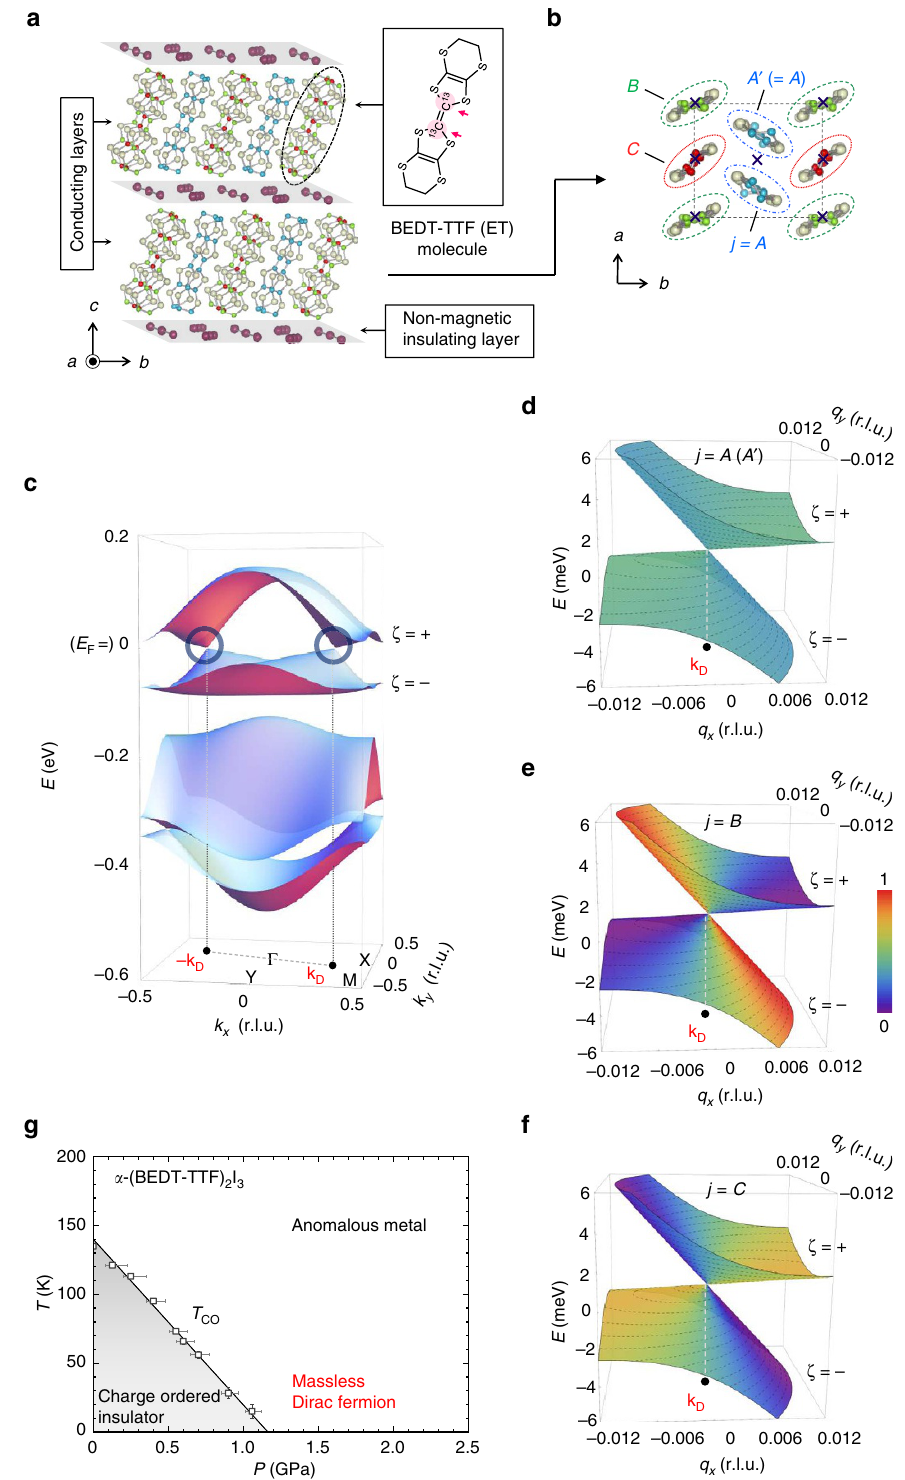
Fig. 1g) on the four molecular sites in the unit cell, j ¼ A , A’ ( ¼ A ), B and C . The two 13 C nuclei (spin I ¼ 1/2) introduced at the centre of BEDT-TTF (ET) molecules (inset of Fig. 1a) are used for 13 C NMR, which are known as a sensitive probe of electronic states at E F in this class of compounds 51 . Figure 2a shows the typical NMR spectra observed at a magnetic field